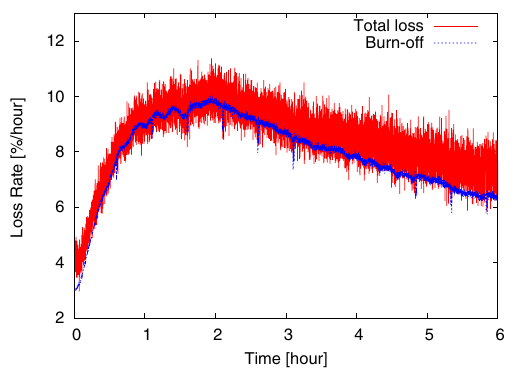
FIG. 10. The beam loss rate and burn-off contribution with 3-d cooling in the 2012 RHIC 96.4 GeV U-U run. Almost all beam loss was from burn-off.